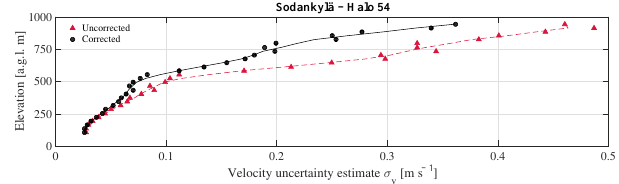
Figure 13. The velocity uncertainty estimate σ v before and after applying the background correction for Halo Doppler lidar mea- surements during 1 September–30 November 2014 at Sodankylä, Finland. Each marker represents the calculated σ v for the range bin in question, and the solid and the dashed lines represent the running medians with a window length of three range